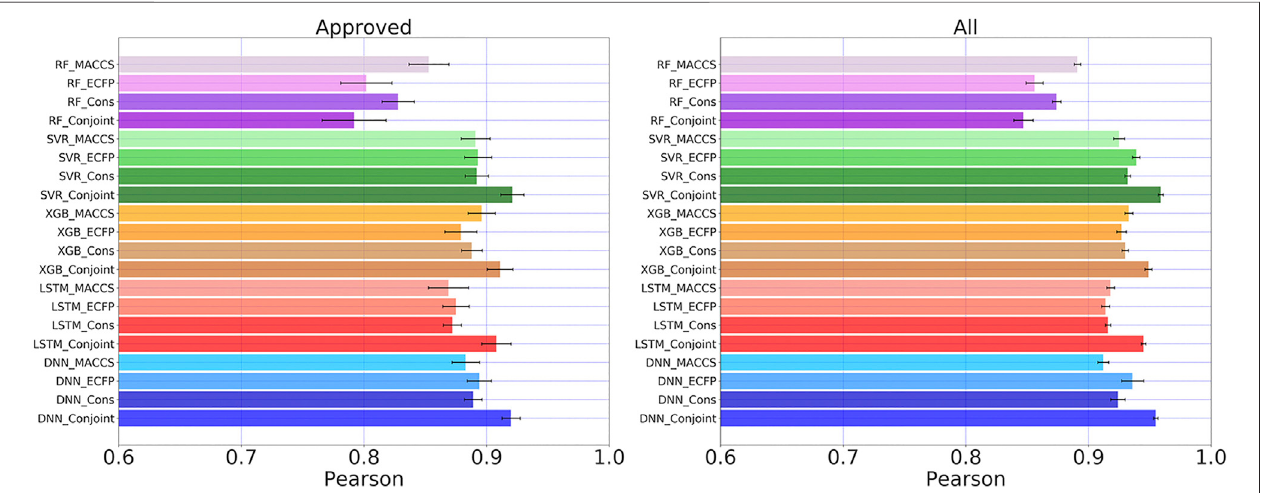
FIGURE 6 | Pearson coef fi cients for “ Approved ” and “ All ” dataset calculated by fi ve learning algorithms using MACCS keys, ECFP, consensus model and the conjoint fi ngerprints. The similar set of color represents one learning algorithm using different molecular fi ngerprints. Error bars were computed from 20 times individual training and testing